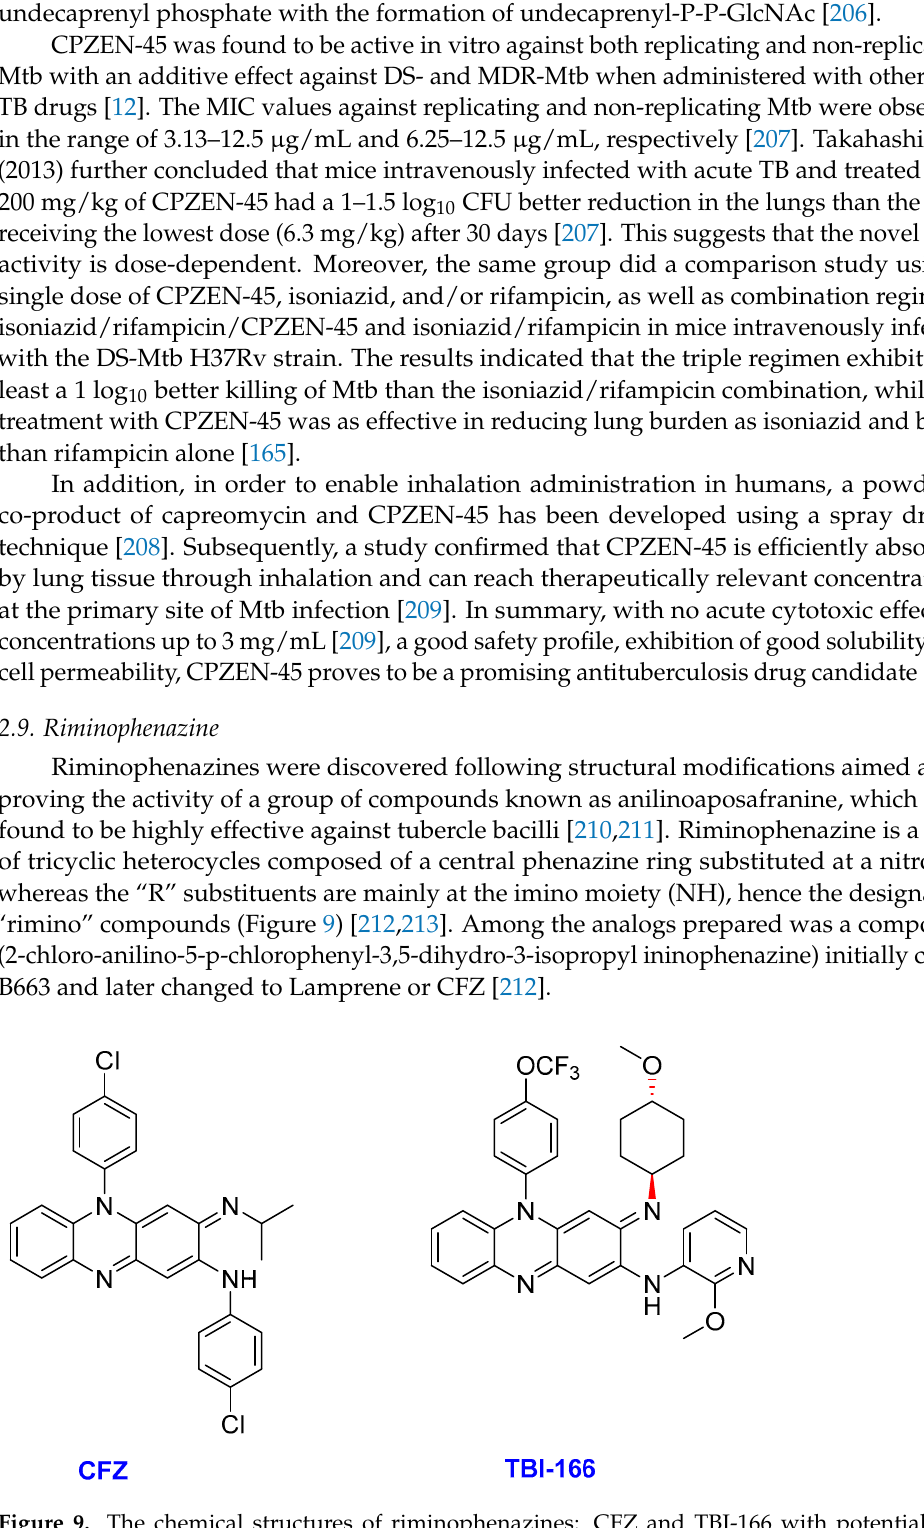
Figure 9. The chemical structures of riminophenazines: CFZ and TBI-166 with potential anti-TB properties.